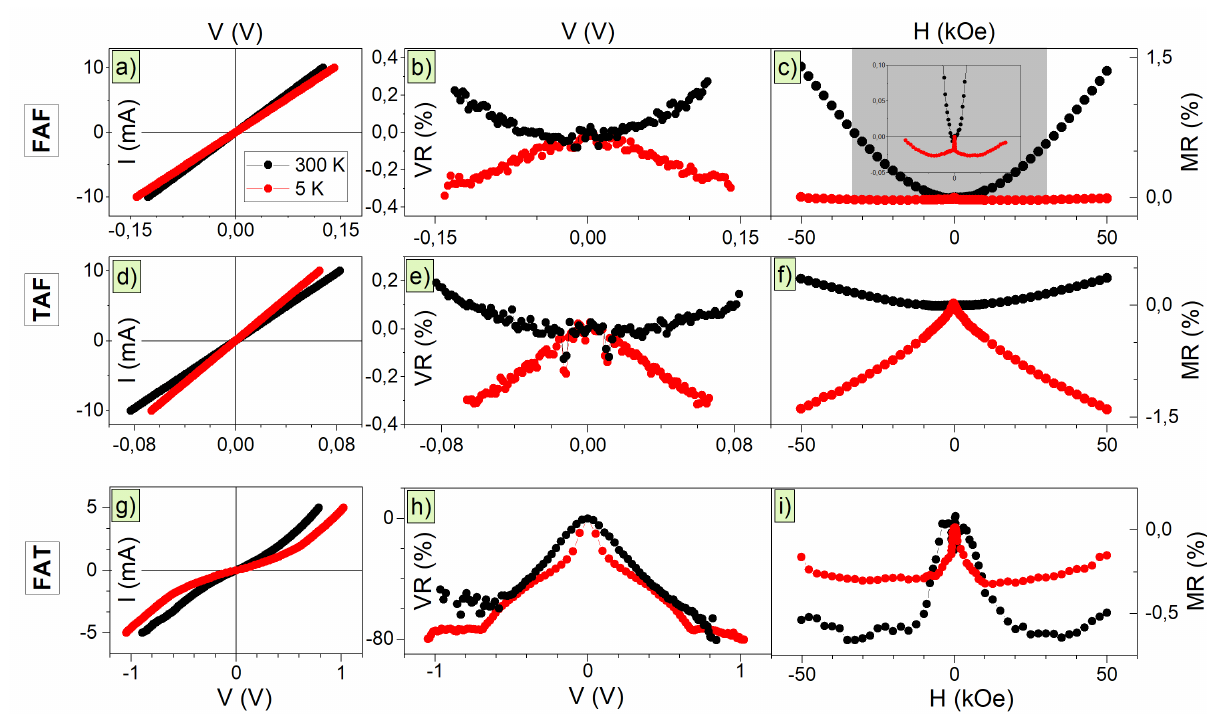
Figure 7. I - V characteristics ( a , d , g ) with changes of differential resistivity induced with voltage VR ( V ) ( b , e , h ) and magnetoresistance MR ( H ) ( c , f , i ) for FAF, TAF, and TAF junctions. Inset of Figure 7c is a magnification of FAF magnetoresis- tance